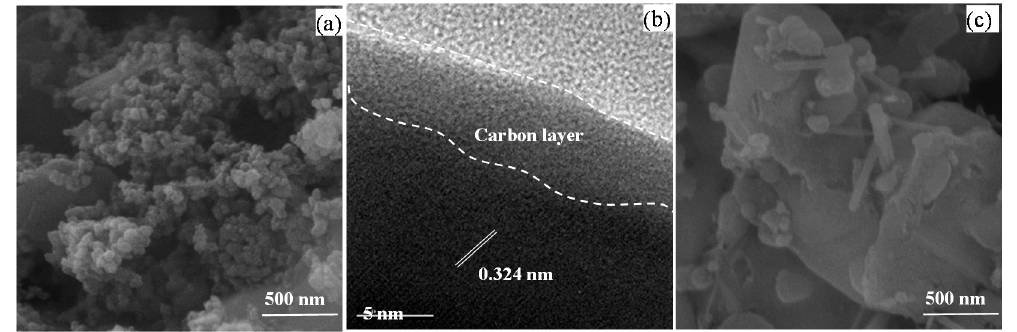
Figure 4. ( a ) SEM and ( b ) HRTEM images of the LVP compounds prepared by the oxalic acid and ( c ) SEM image for the citric